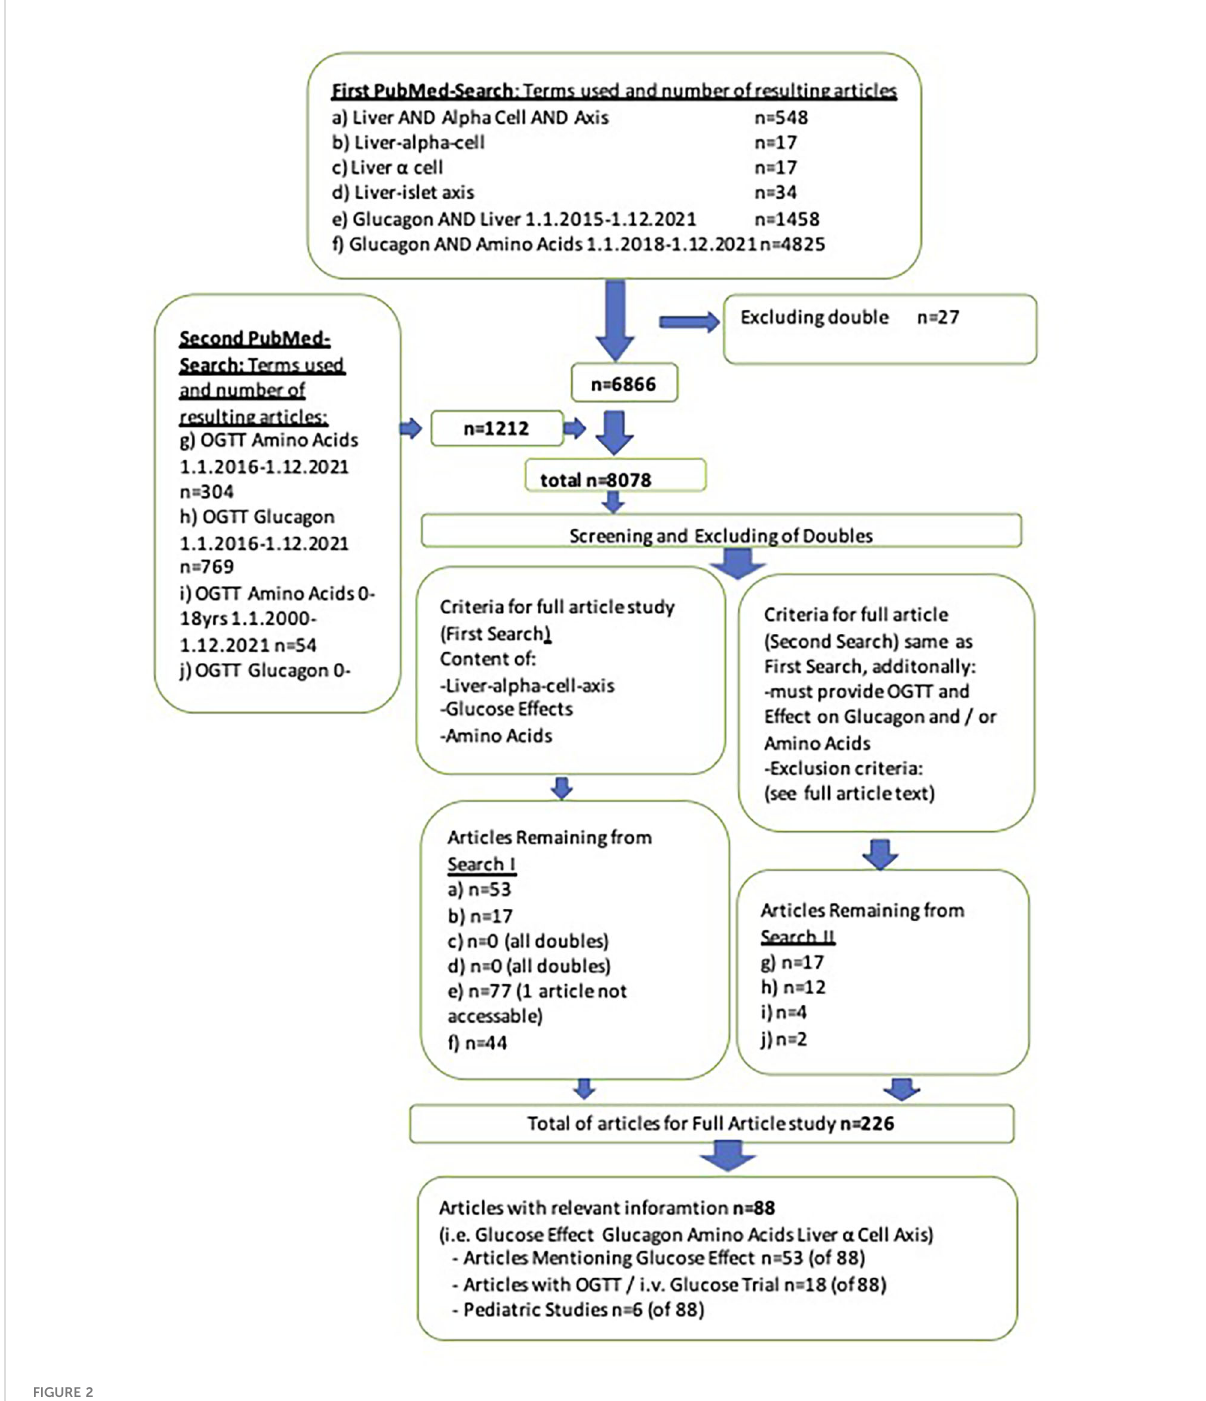
FIGURE 2 PRISMA- fl ow chart of literature